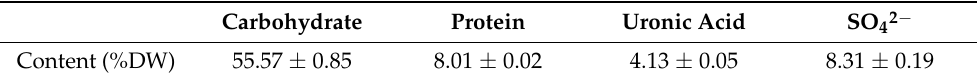
Table 3. Analysis of biochemical composition of intracellular